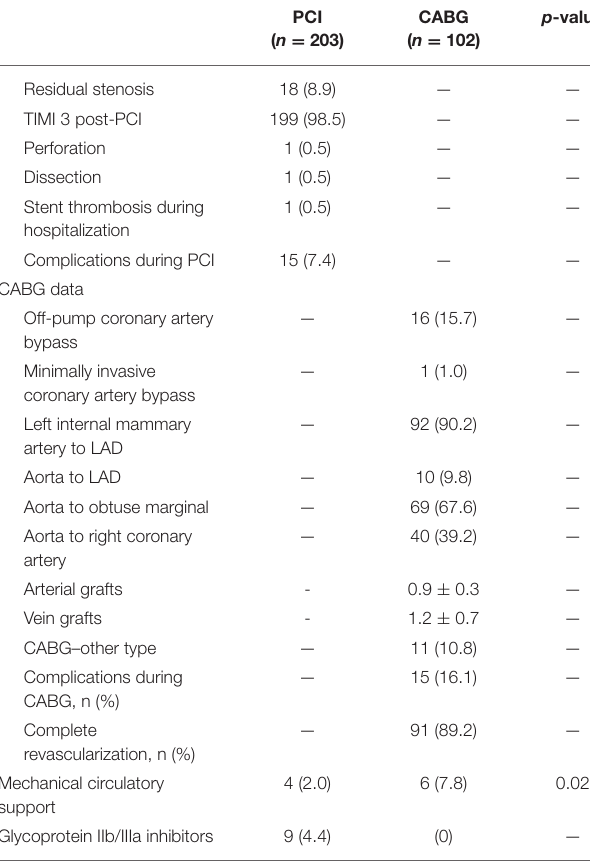
TABLE 2 | Angiographic, procedural, and medication data according to the type of treatment.